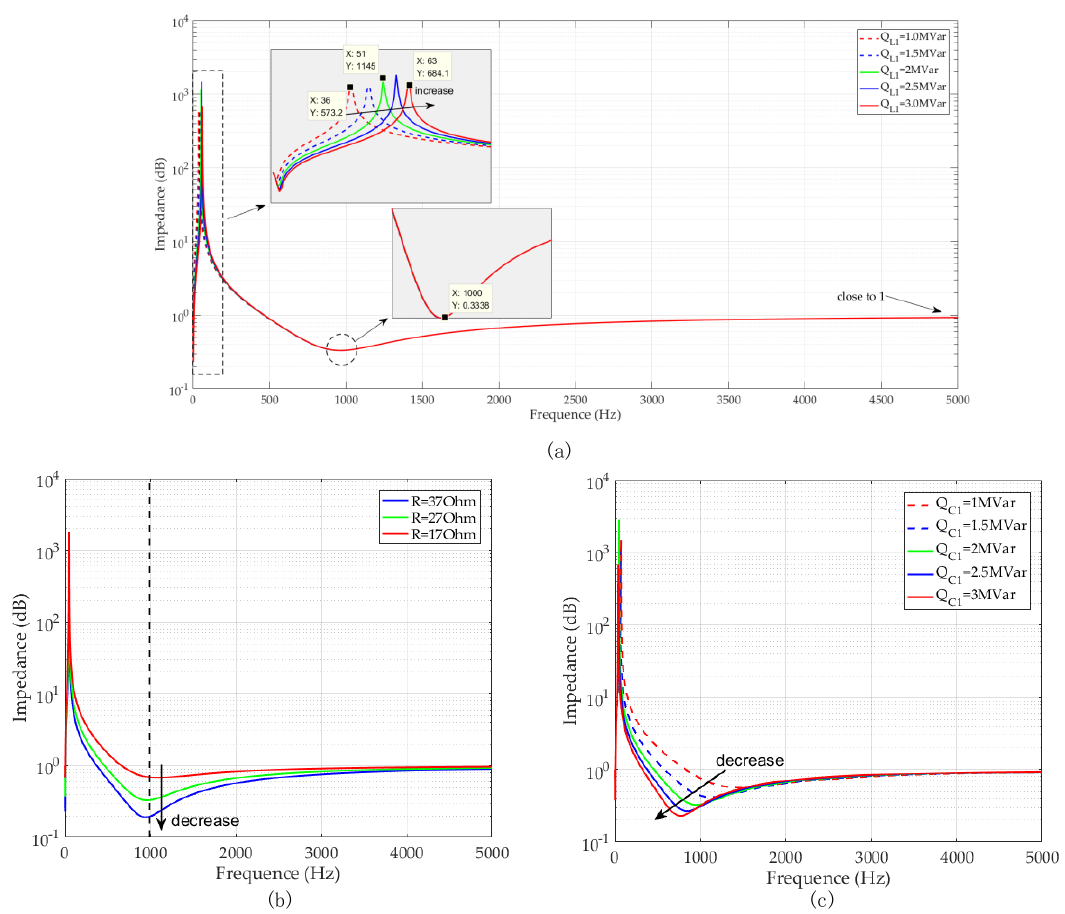
Figure 4. Resonance Damping Analysis. ( a ) Impedance-frequency response determined by different L 1 ; ( b ) Impedance-frequency response determined by different R; ( c ) Impedance-frequency response determined by different C 1 .